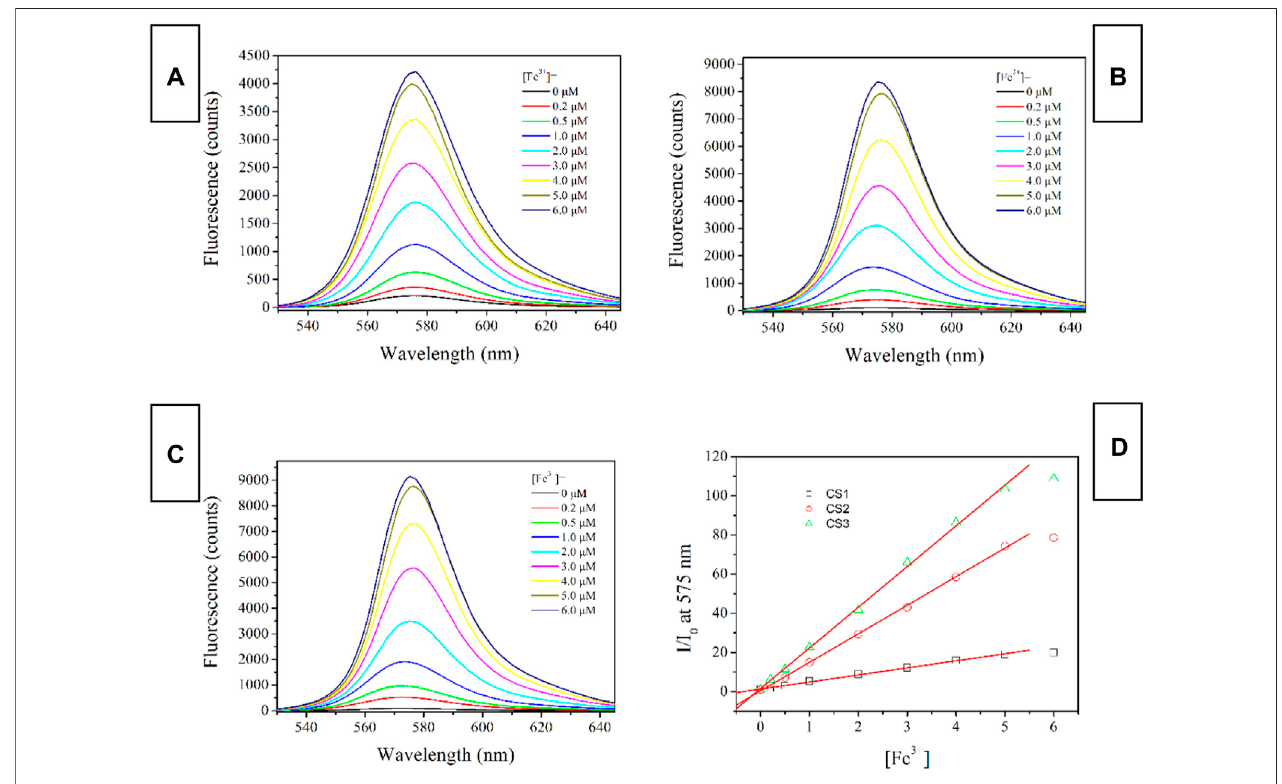
FIGURE 3 | Emission spectra of chemosensors (10 μ M) with the addition of Fe 3+ (0.0 – 6.0 equiv) in the aqueous (containing 5% ethanol as a co-solvent), (A) , CS1; (B) , CS2; (C) , CS3; (D) , I/I 0 variation at 575 nm of these chemosensors. Here I means fl uorescence intensity and I 0 is the fl uorescence intensity without Fe 3+ .